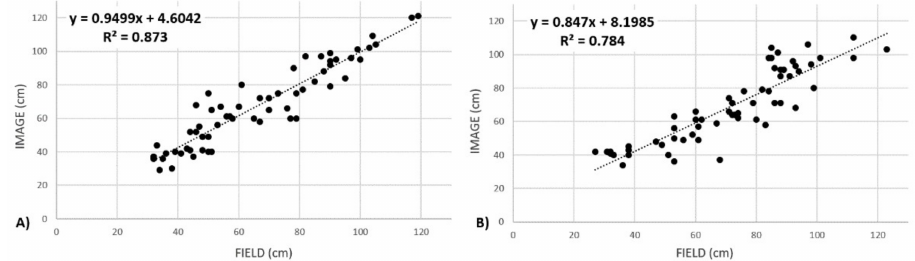
Figure 3. Linear regression, R 2 , and estimation equation for the height ( A ) and crown diameter ( B ) variables, in centimeters